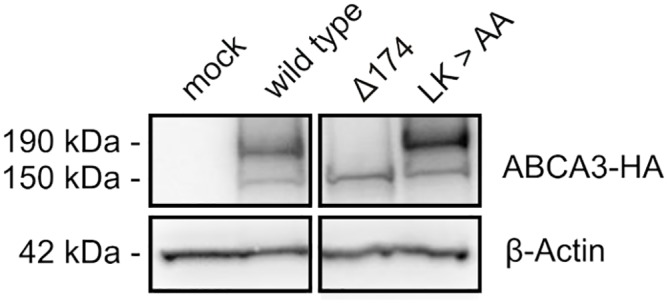
Mutation of potential Cathepsin cleavage sites.Amino acids forming potential cleavage sites were replaced by alanine residues using site directed mutagenesis. Lane 1: cells transfected with empty vector; lane 2: wild type ABCA3; lane 3: deletion of the first 174 amino acids of ABCA3; lane 4: 173LK174 > AA.